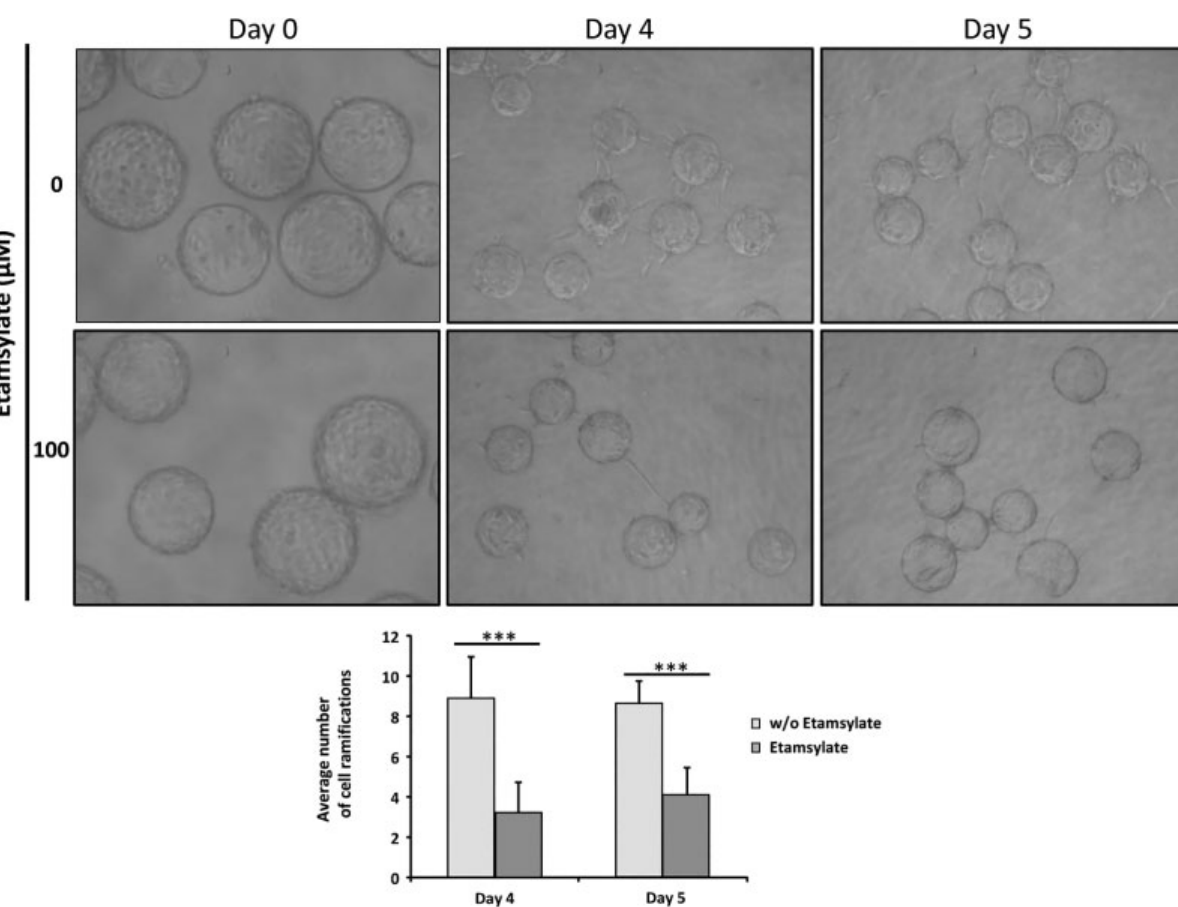
Fig.4 3Dangiogenesis. HUVEC-coated beads were cultured inthe presence or absence ofetamsylate during 5 days. When etamsylate ispresent, fewer bonds can be observed between neighboring beads forming a network, as it occurs in control conditions. There was a signi fi cantly higher number of rami fi cations in control (untreatedcells) comparedwith etamsylate-treated cells, as the graph shows(day 4, (cid:3)(cid:3)(cid:3) p < 6.5 (cid:1) 10 (cid:5) 4 ; day 5, (cid:3)(cid:3)(cid:3) p ¼ 8.34 (cid:1) 10 (cid:5) 5 ). HUVECs, human umbilical vein endothelial